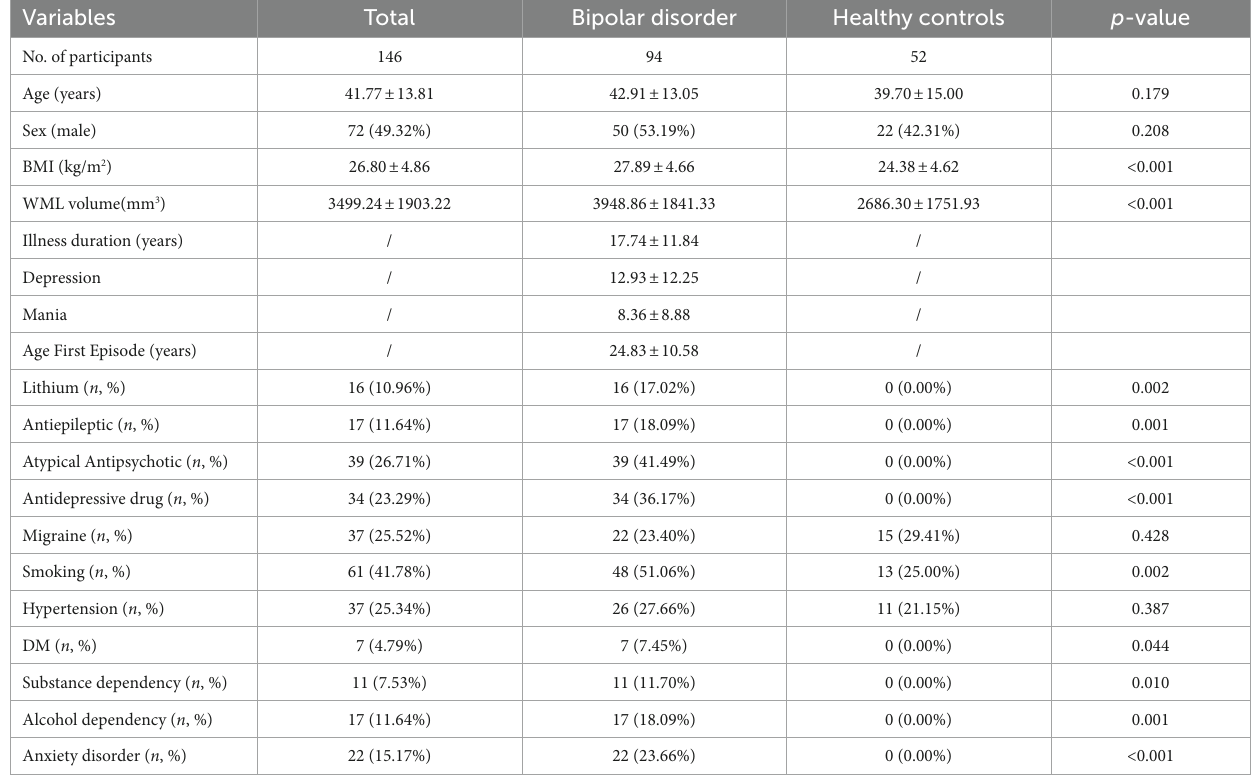
TABLE 1 Baseline characteristics of participants with or without Bipolar Disorder ( N =